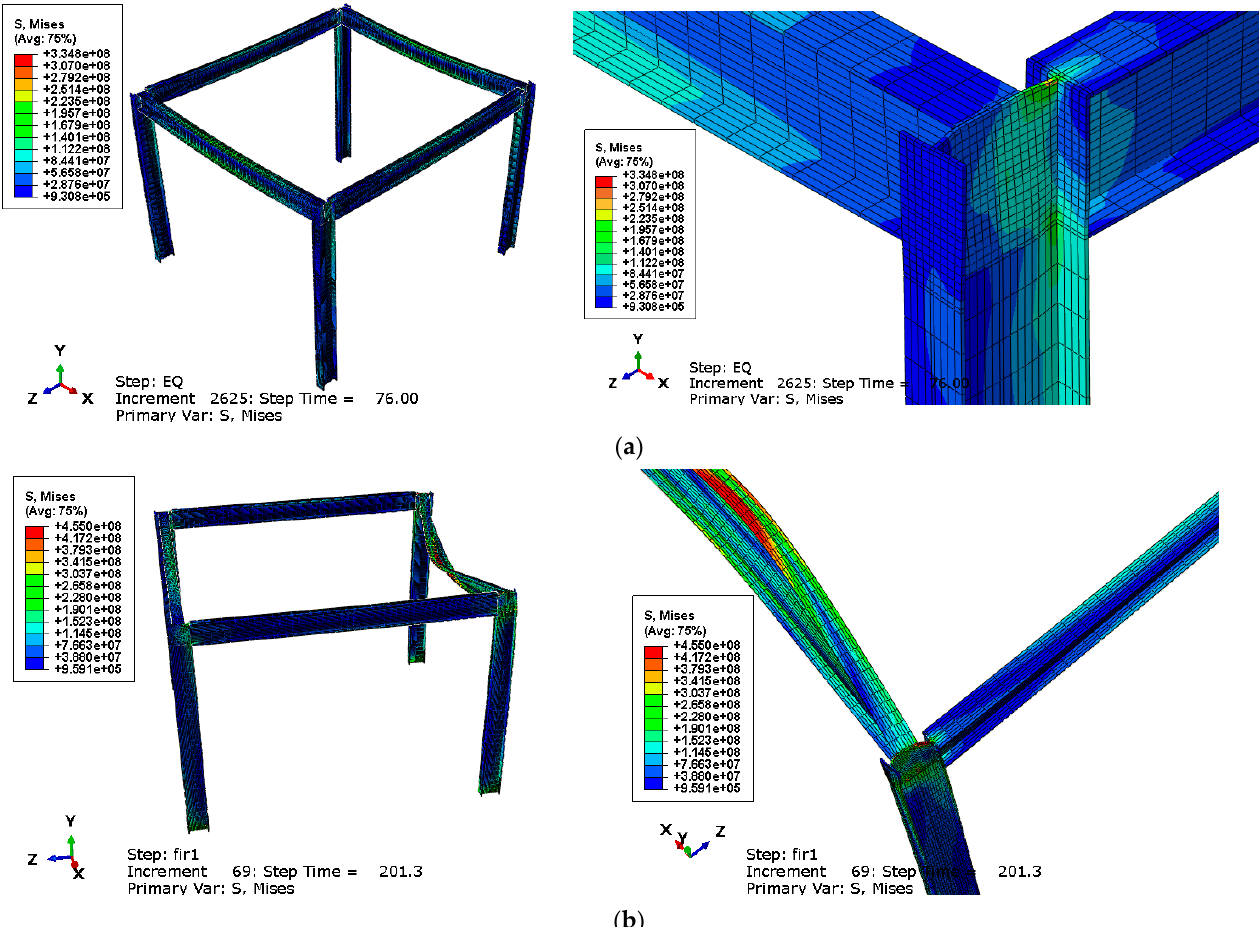
Figure 12. Images from a Case II PEF analysis with a real earthquake (PGA = 0.35 g, natural period = 0.36 sec) one-directional excitation in the z-direction, including ( a ) the residual deformation of the structure at the end of earthquake event and ( b ) the shape and mechanism of failure of the structure after the PEF event.